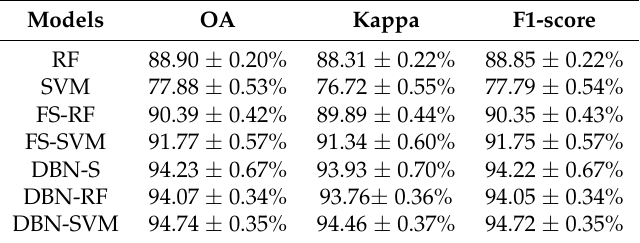
Table 7. Overall performance of different models. RF: random forest. SVM: support vector